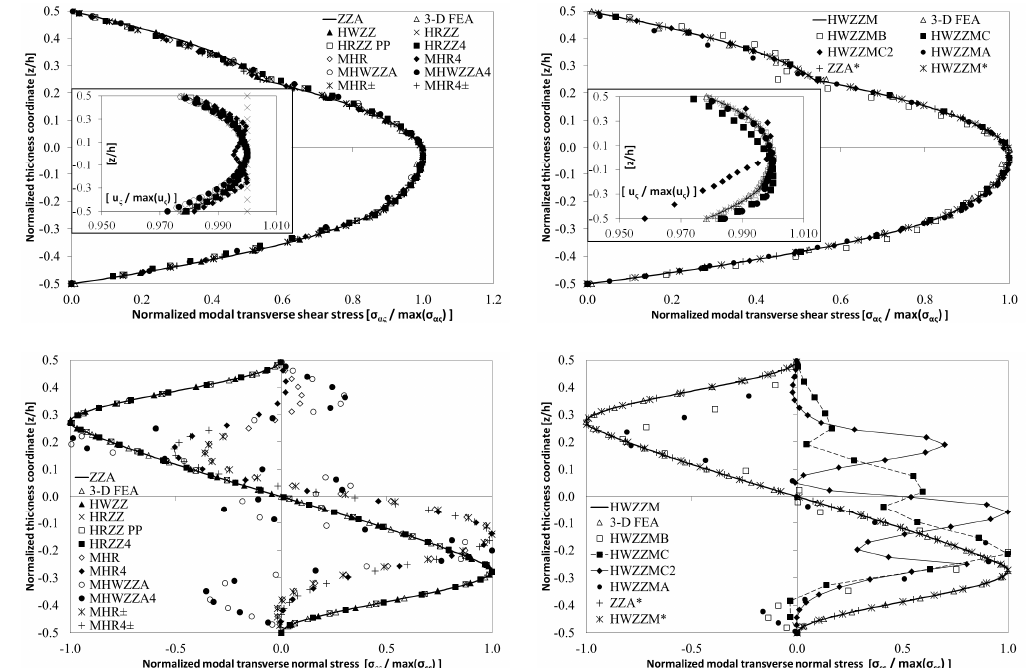
Figure 6. Case c1: Normalized modal displacements and stresses of a simply supported laminated plate ( L x/ h = 5, E 1 /E 2 = 3).